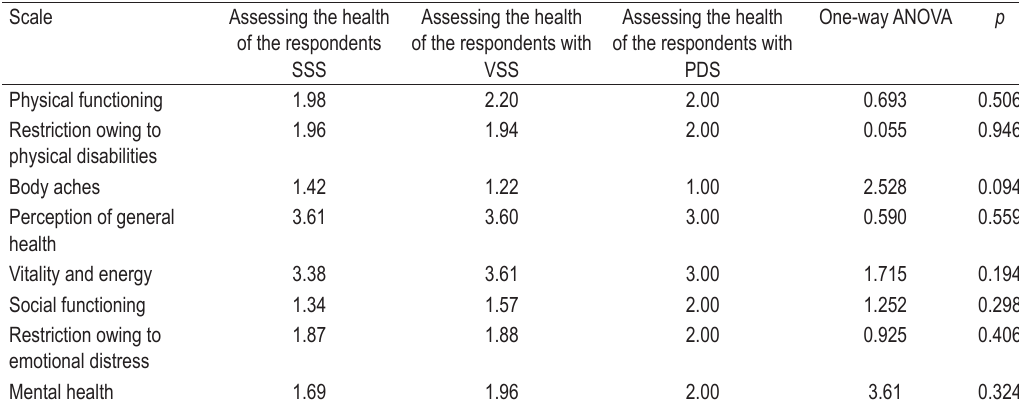
TABLE 4. Education level and health of respondents (one-way ANOVA) Scale